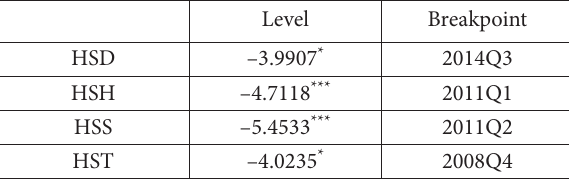
Table 3. Zivot and Andrew unit root test